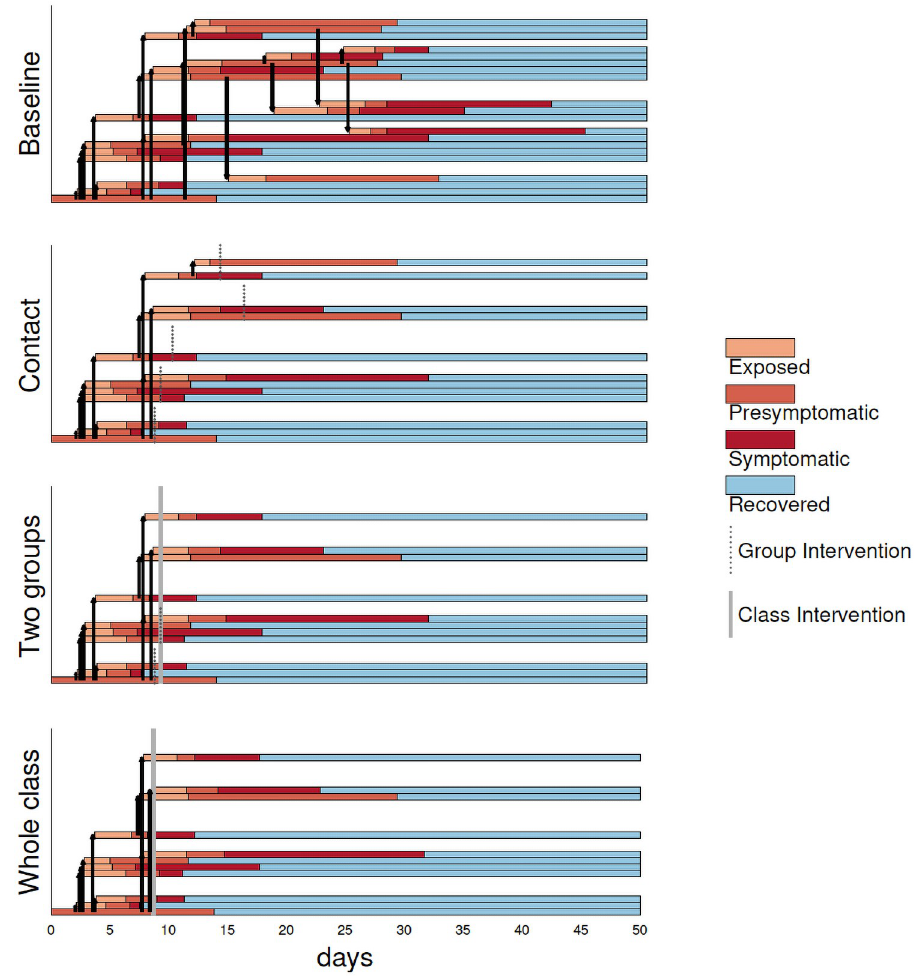
Fig 2. The four protocols applied to a cluster where the index case is asymptomatic and has high transmission and where the class has medium transmission. In all interventions, if individuals have not already been identified through the relevant protocol, transmission stops when symptoms begin (red to purple) as symptomatic individuals do not attend (or they leave when symptoms